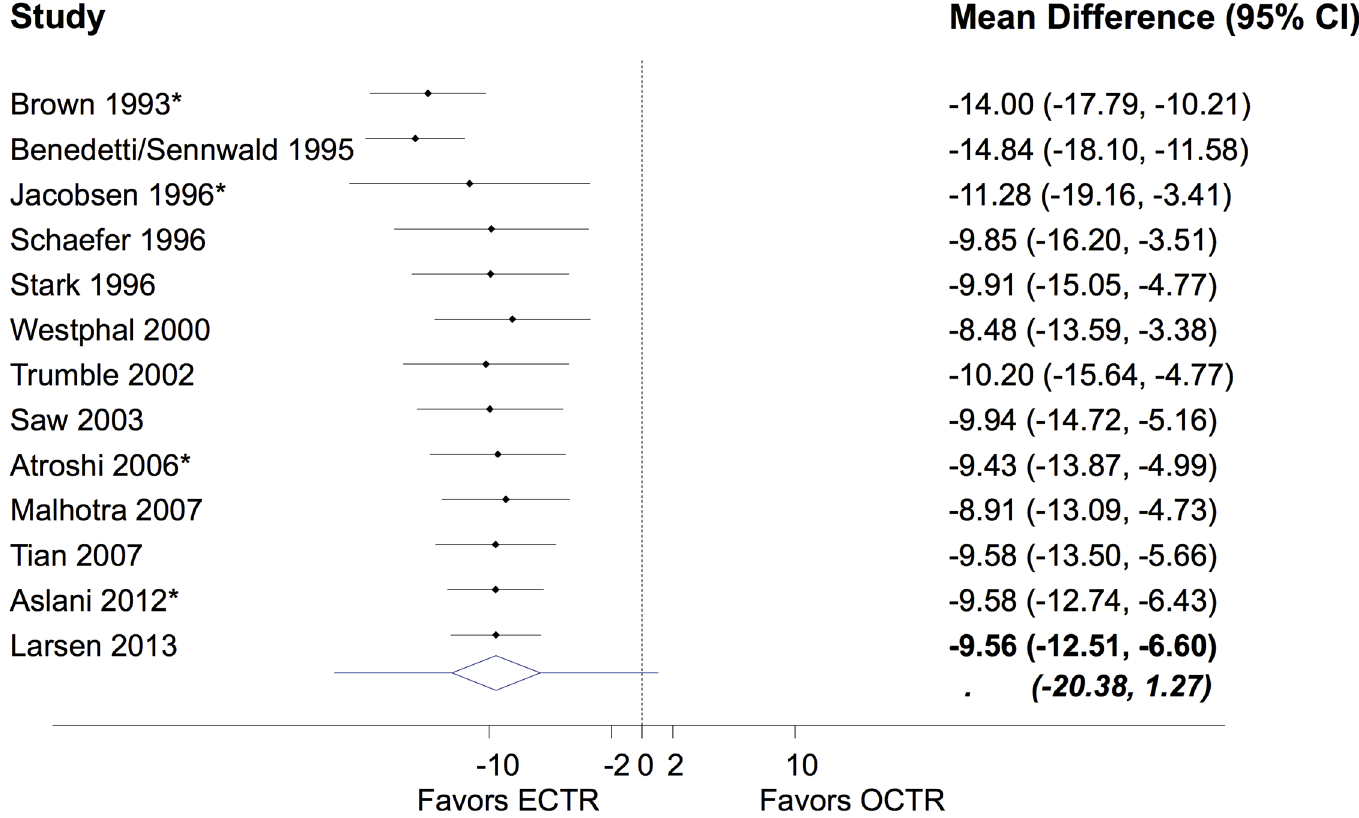
Fig 4. Cumulative mean difference (MD) and 95% confidence interval (CI) for complications time to return to work or daily activities. The extended lines outside the diamond in the final meta-analytic summary shows the 95% prediction intervals. Asterisk indicates that the study has used a two-portal